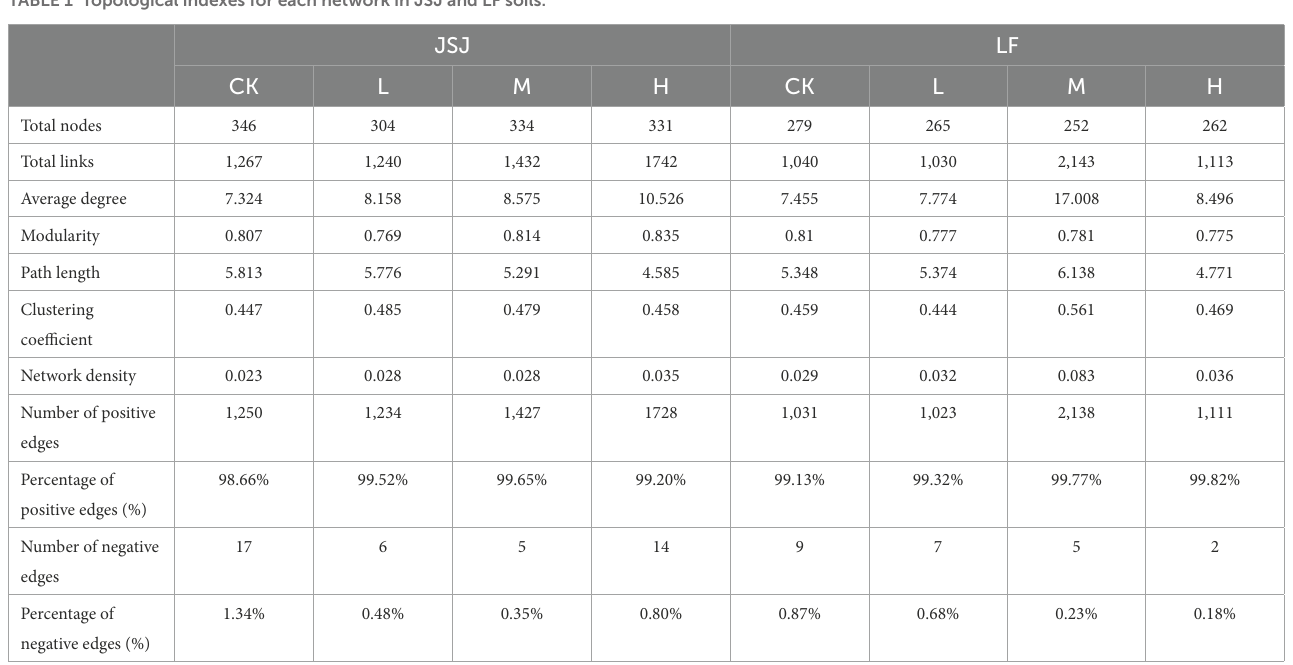
TABLE 1 Topological indexes for each network in JSJ and LF